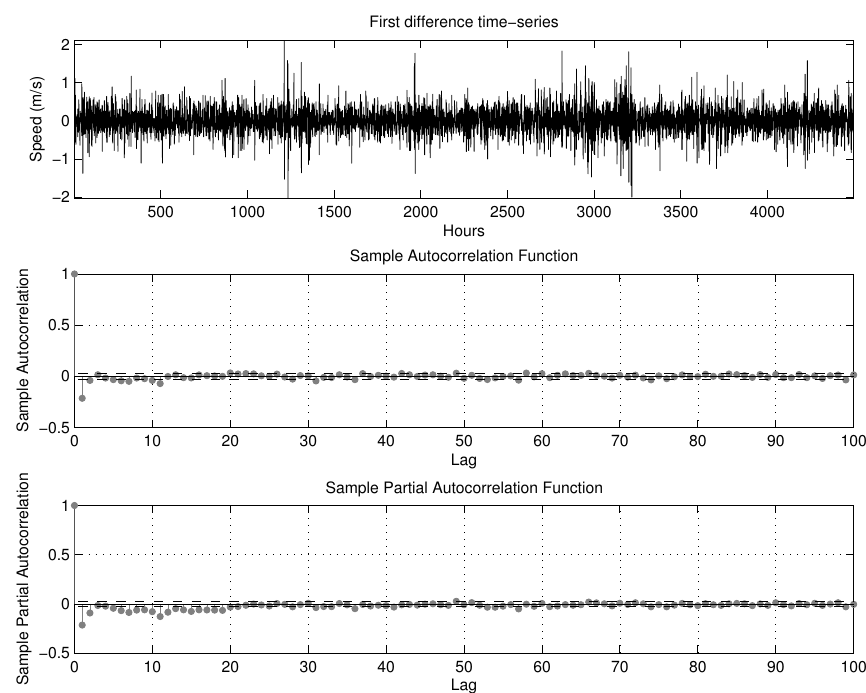
Figure 9. Differentiated original time series wind speed, ACF and PACF plots at